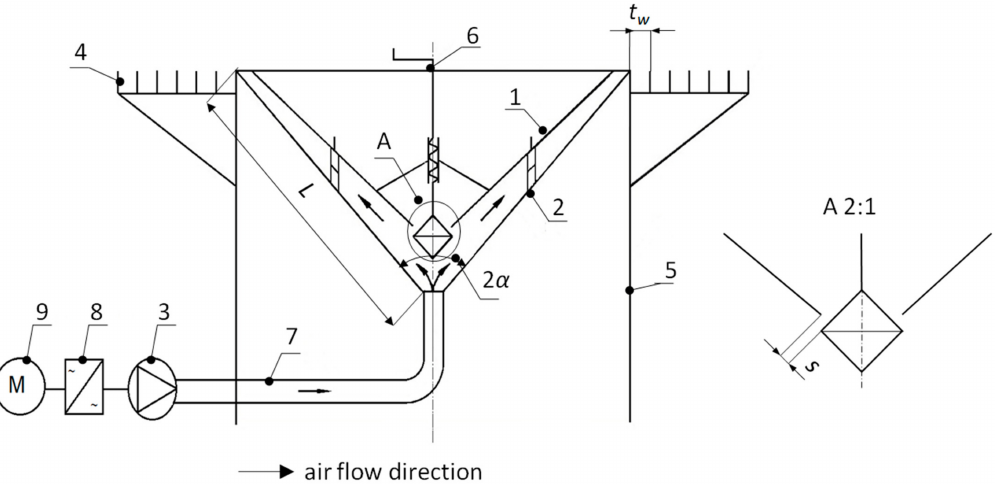
Figure 2. Diagram of the test stand: 1—inner cone working surface, 2—outer cone surface, 3—fan, 4—troughs, 5—base, 6—knob for infinitely variable adjustment of the charging slot, 7—air duct, 8—power inverter, 9—electric motor, 2 α —cone’s apex angle, L —length of the cone’s generating line, s —width of the grain inlet, t w —through